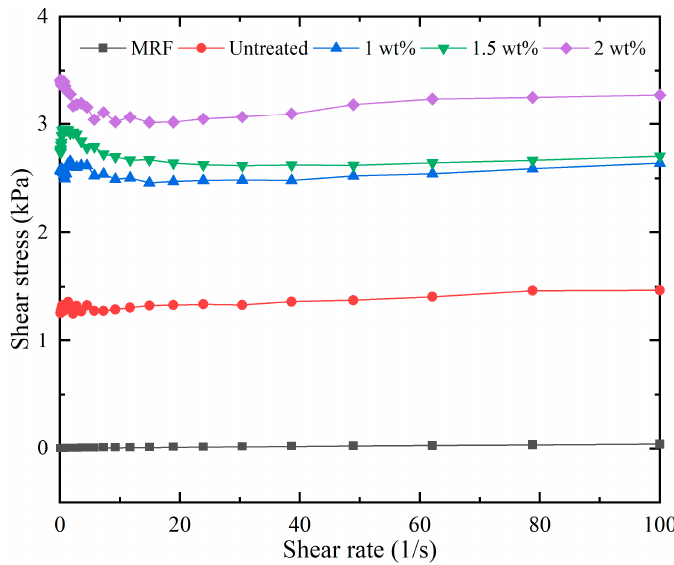
Figure 6. Variation of shear stress with shear rate under zero-field.